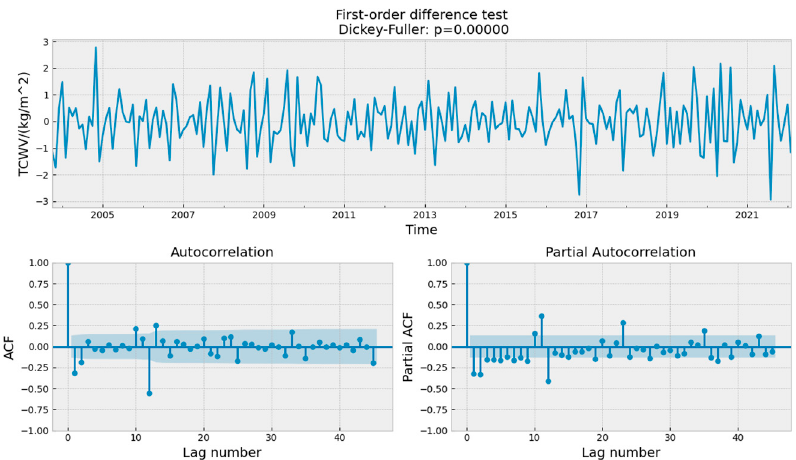
Figure 9. Time series, autocorrelation and partial autocorrelation of TCWV after first-order differ- ence.